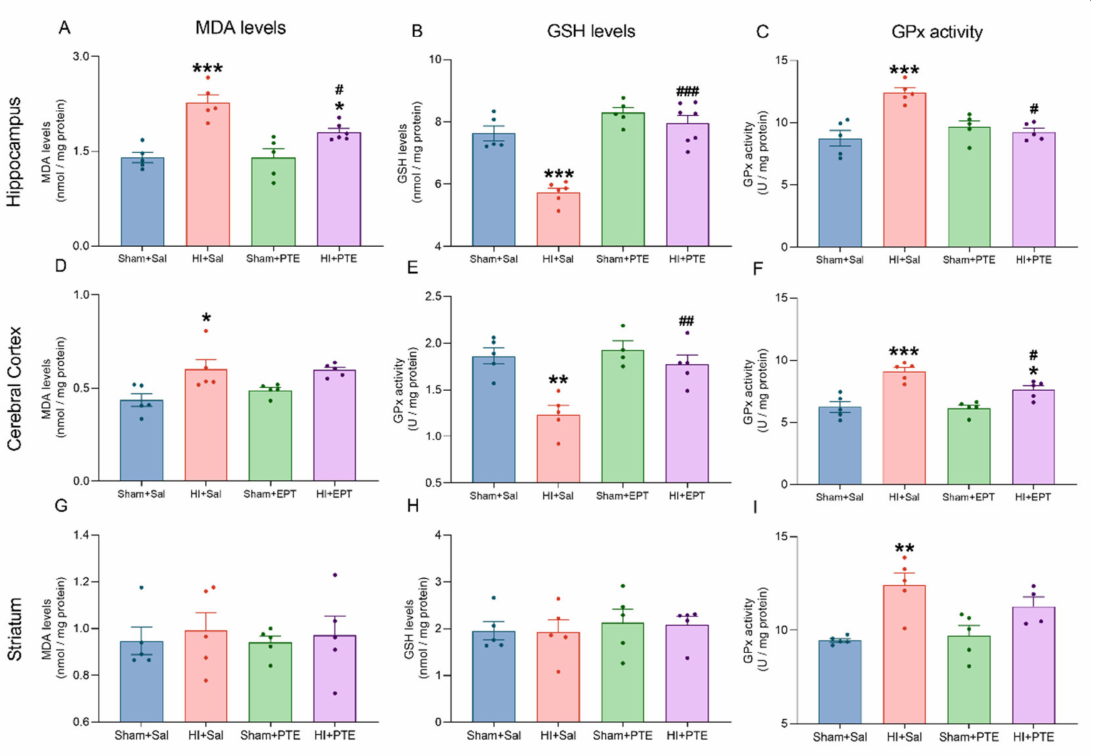
Figure 3. HI-induced oxidative stress biomarker responses. Data are expressed as mean ± SEM. Malondialdehyde (MDA) levels, reduced glutathione (GSH) levels, and glutathione peroxidase (GPx) activity were essayed in the Hippocampus (( A – C ), respectively), in the Cerebral Cortex ( D – F ), and in the Striatum ( G – I ). * Injury effect (HI vs. control). # Treatment effect (Sal vs. PTE). Sham + Sal ( n = 4–5); HI + Sal ( n = 4–6); Sham + PTE ( n = 4–7); HI + PTE ( n = 4–7). Significance was